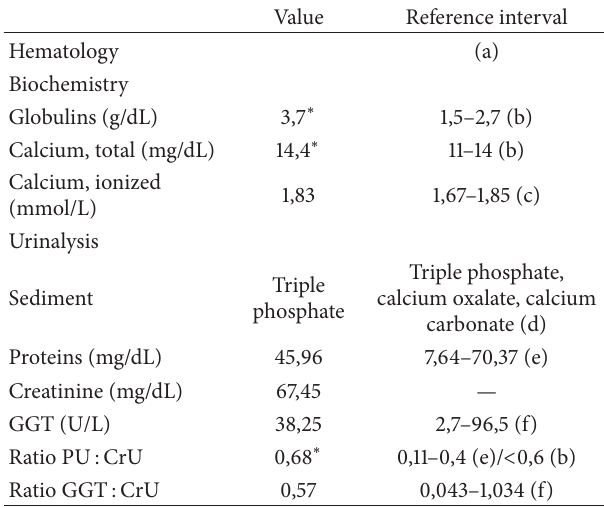
of congenital ventricular septal defects, one case of incom- plete tracheal rings, various cases of cutaneous asthenia, one case of bilateral tibial agenesis, two cases of congenital uterine malformations, congenital cataracts, and one corneal dermoid [17–26]. Syndactyly has not been reported in pet rabbits.